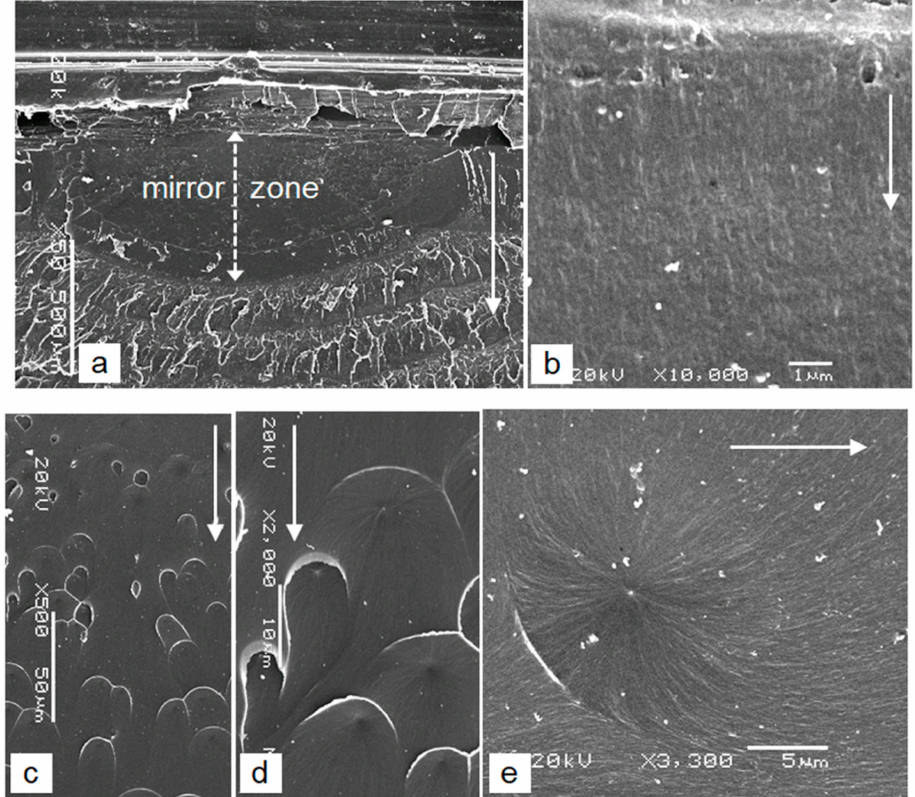
Figure 7. Characteristics of the mirror zone of the sample of series D ( a ) symmetric semi-elliptic form of the mirror zone ( b ) lines in the direction of the main crack ( c ) di ff erent tips of contours in the crack surface of the mirror zone ( d ) parabolic markings with the initials in their focus ( e ) micro-crater with the initial in its center; the solid arrows indicate the direction of the main crack